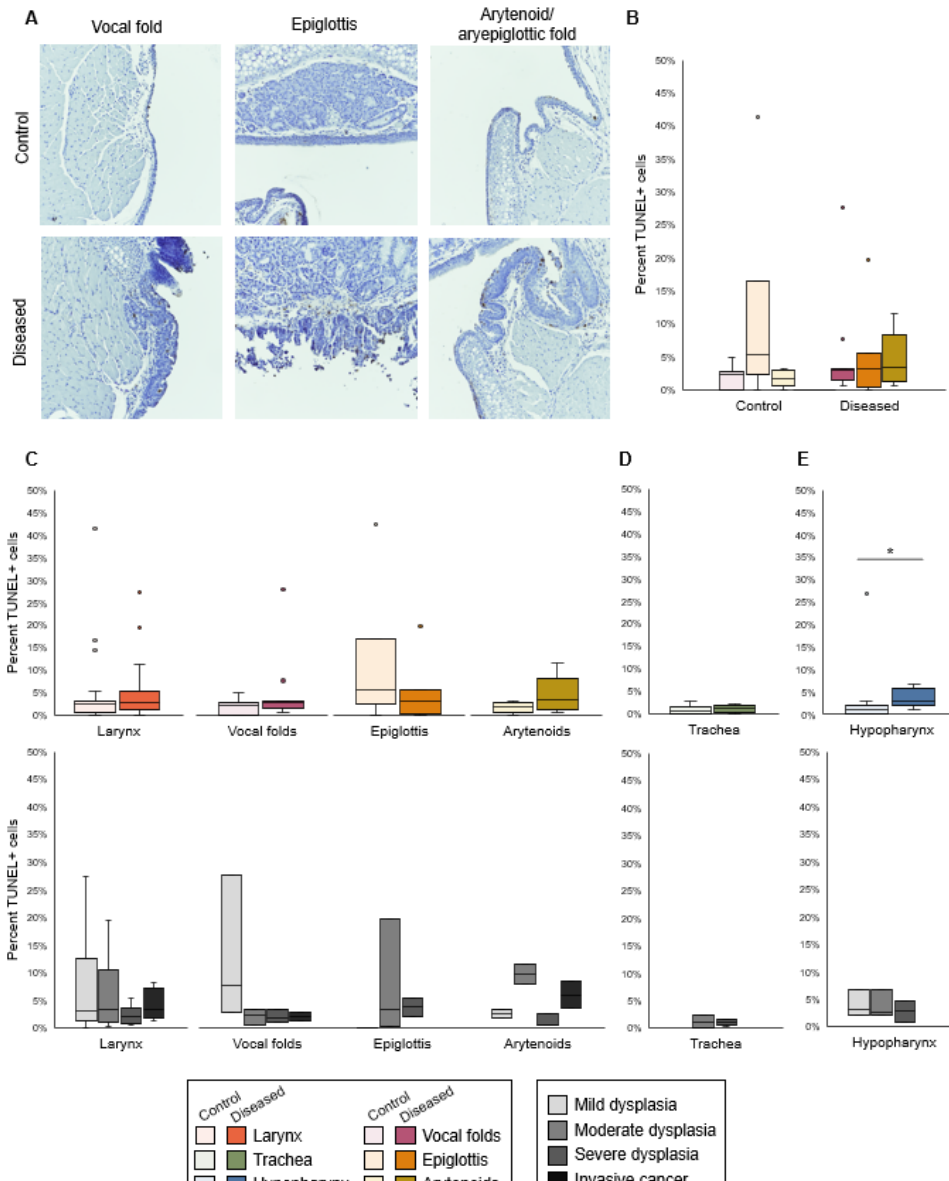
mice per disease stage; arytenoids p = 0.1375, n = 2–6 mice per disease stage. *Significant post hoc DSCF pairwise tests: moderate vs. severe laryngeal dysplasia p = 0.0482, severe laryngeal dysplasia vs. invasive cancer p = 0.0464. All other pairwise tests: p > 0.05. ( D ) Control vs. diseased trachea and disease severity in